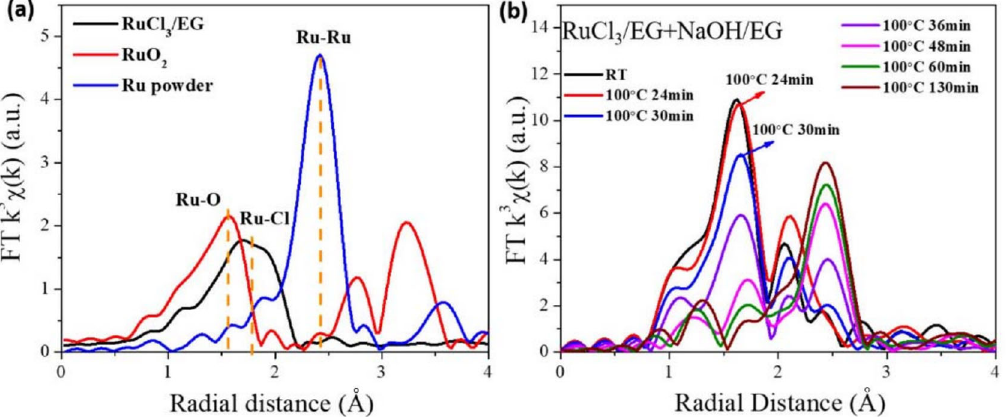
Figure 2. Fourier transforms of k 3 ‐ weighted Ru K ‐ edge EXAFS spectra (radial distribution function). ( a ) The reference of Ru powder, RuCl 3 glycol solution and RuO 2 powder; ( b ) the reaction mixture for preparing unprotected Ru nanoclusters under different conditions. Reproduced with permis ‐